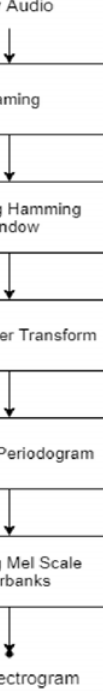
Figure 1. Feature Extraction